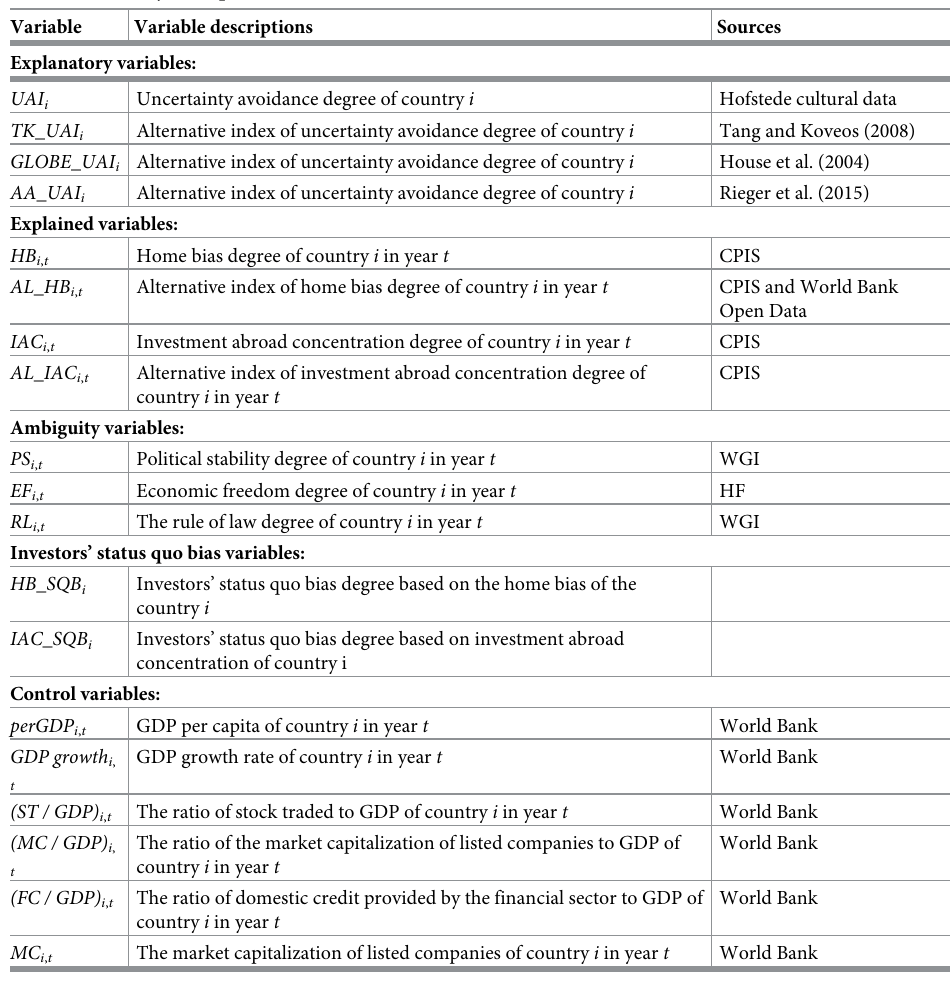
Table 2. Summary descriptions and data sources of